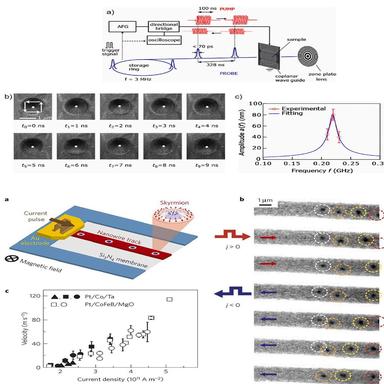
a) Schematic experimental setup for stroboscopic pump–probe time resolved magnetic transmission soft Xray microscopy in 2-bunch mode operation of the storage ring. b) Sequence of MTXM images for delay times between pump and probe between 0 ns and 9 ns showing the gyrational motion of the vortex core (white point). The arrows indicate the orientation of the in -plane magnetization following the shape of the disk. c) Amplitude of gyrational motion as function of the excitation frequency. The fitting line (blu